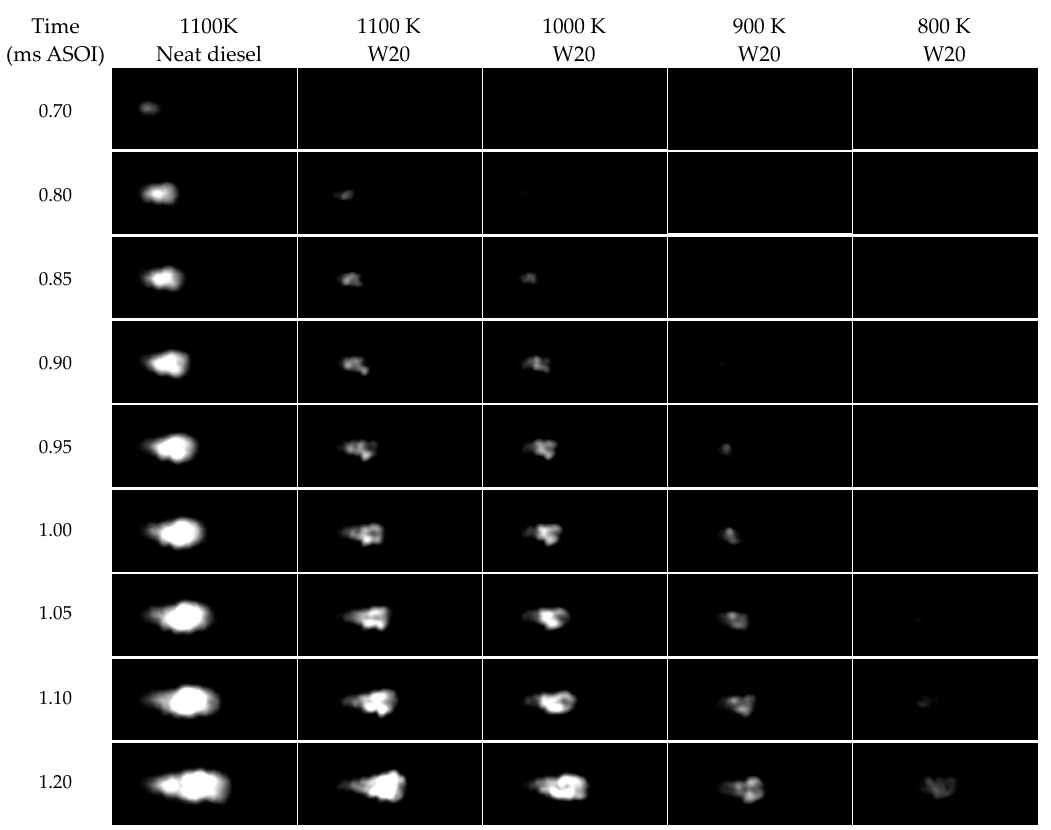
Figure 8. Ignition and combustion processes of neat diesel under 1100 K and W20 under various ambient temperatures.